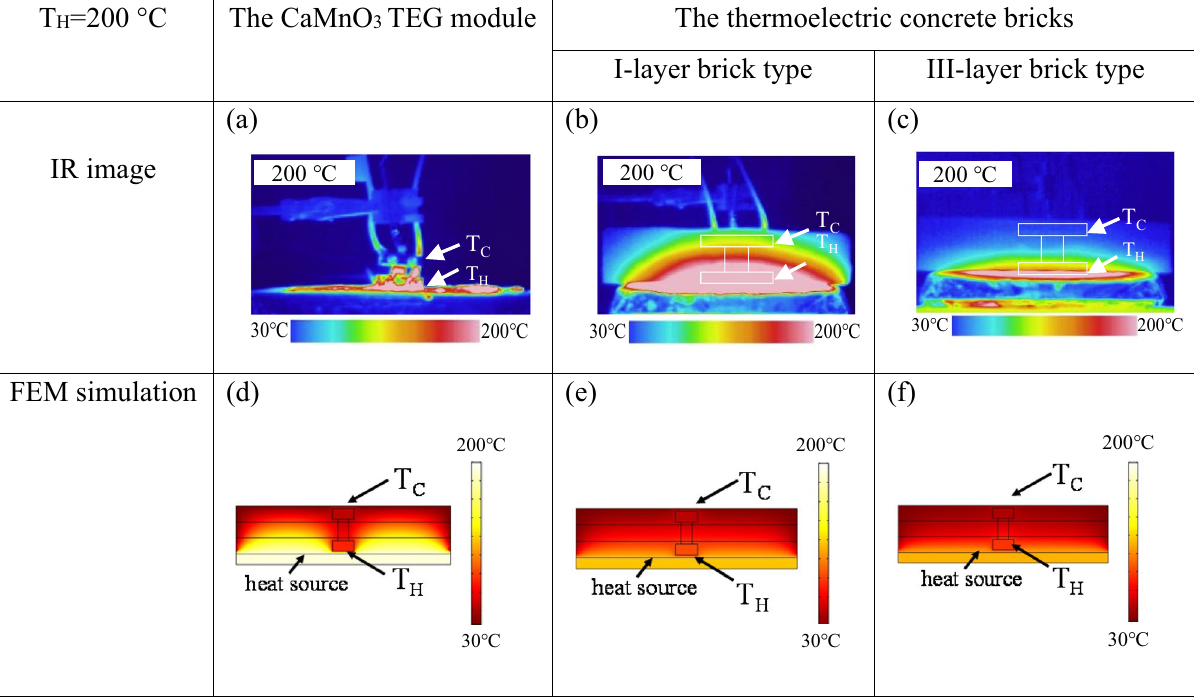
Figure 8. Thermal distribution image of the CaMnO 3 TEG module without a thermal insulator and the thermoelectric concrete bricks of the I-layer brick type and the III-layer brick type upon applying a hot side temperature at 200 °C: ( a – c ) experimental results from the infrared image using Keysight Technologies, U5856A (https:// www. keysi ght. com/), and ( d – f ) computation results from the FEM simulation using COMSOL